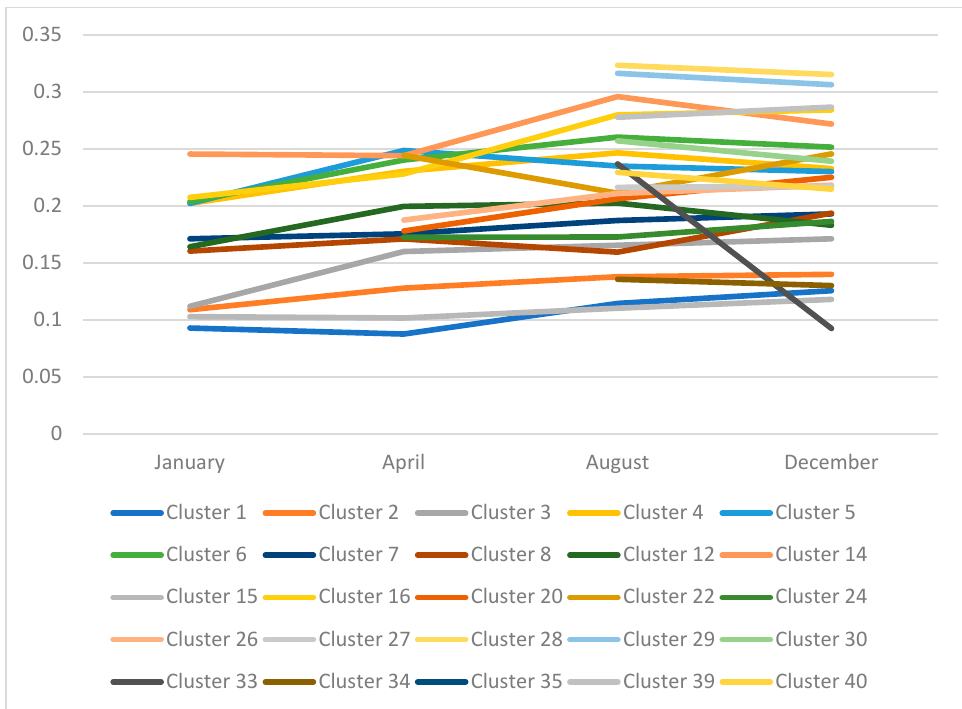
Figure 6. Evolution of the clusters by quarter with LAMDA.